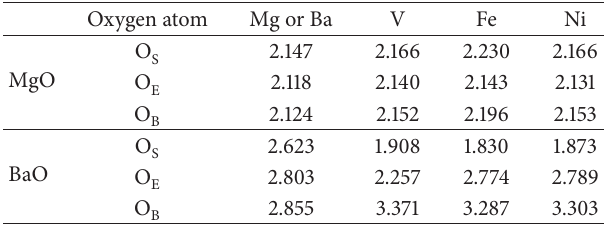
Table 1: Equilibrium distances (˚A) between the doping atom (Mg or Ba atom in the case of undoped surface) and the nearest O atoms. O S corresponds to the superficial oxygen atom, O E corresponds to the equatorial oxygen atoms, and O B corresponds to the bottom oxygen atom. Oxygen atom Mg or Ba V Fe Ni